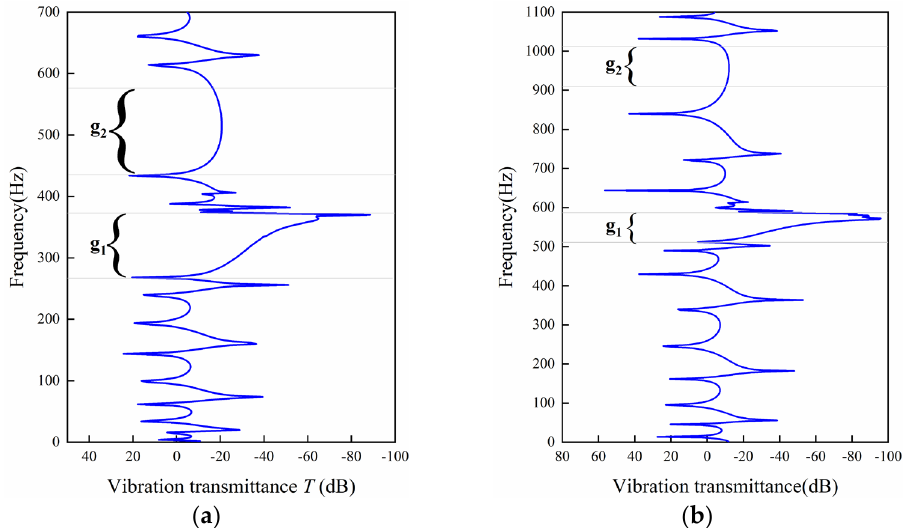
Figure 5. The vibration transmittance of finite plate composed of 1 × 10 unit cells: ( a ) with fluid loading; ( b ) without fluid loading.